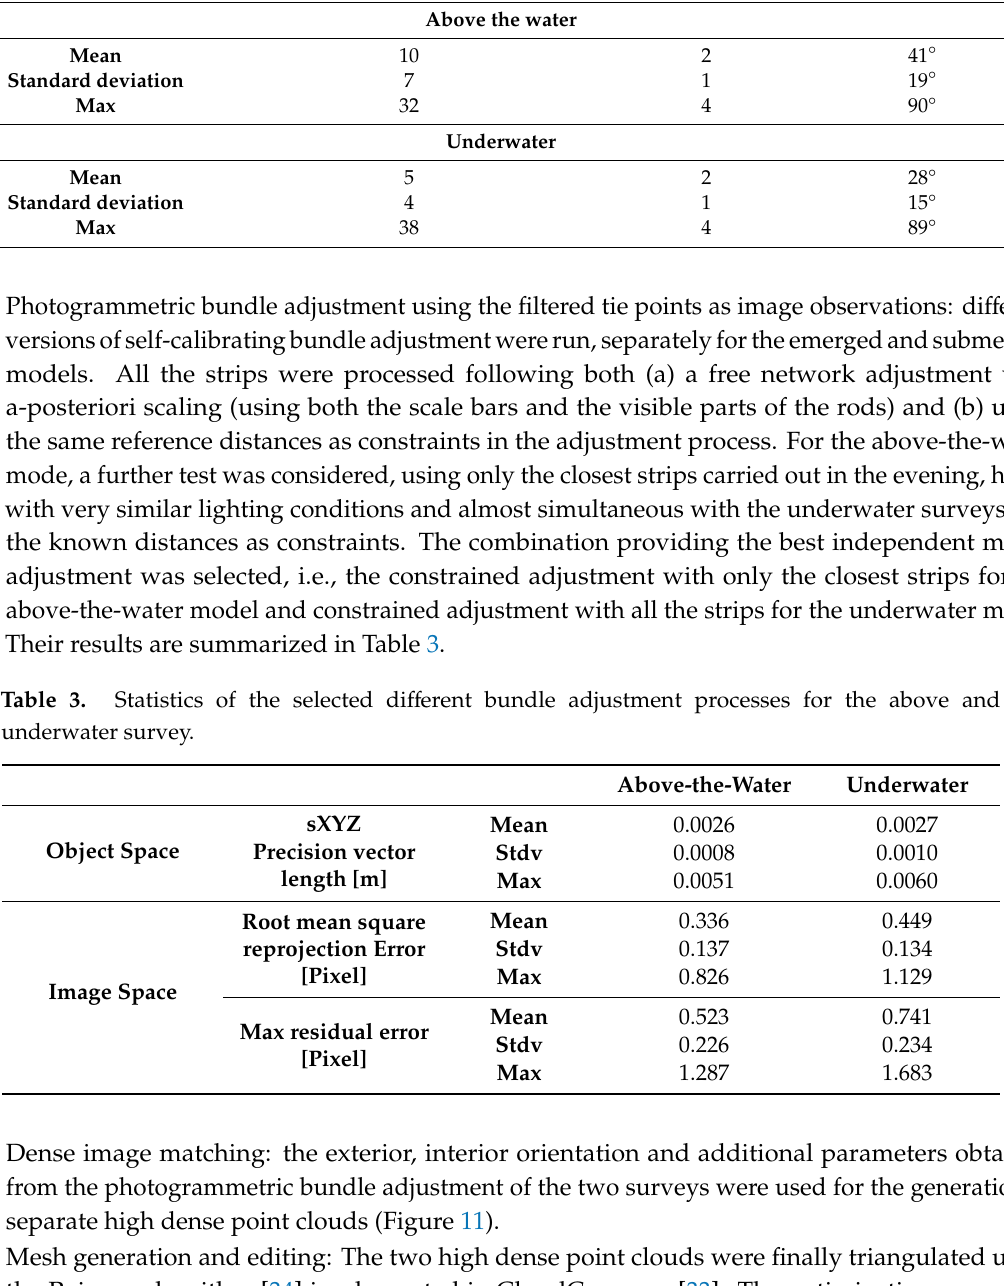
Table 2. Characteristics of filtered sparse tie point clouds above and under-the-water photogrammetric models. Number of Intersecting Optical Rays